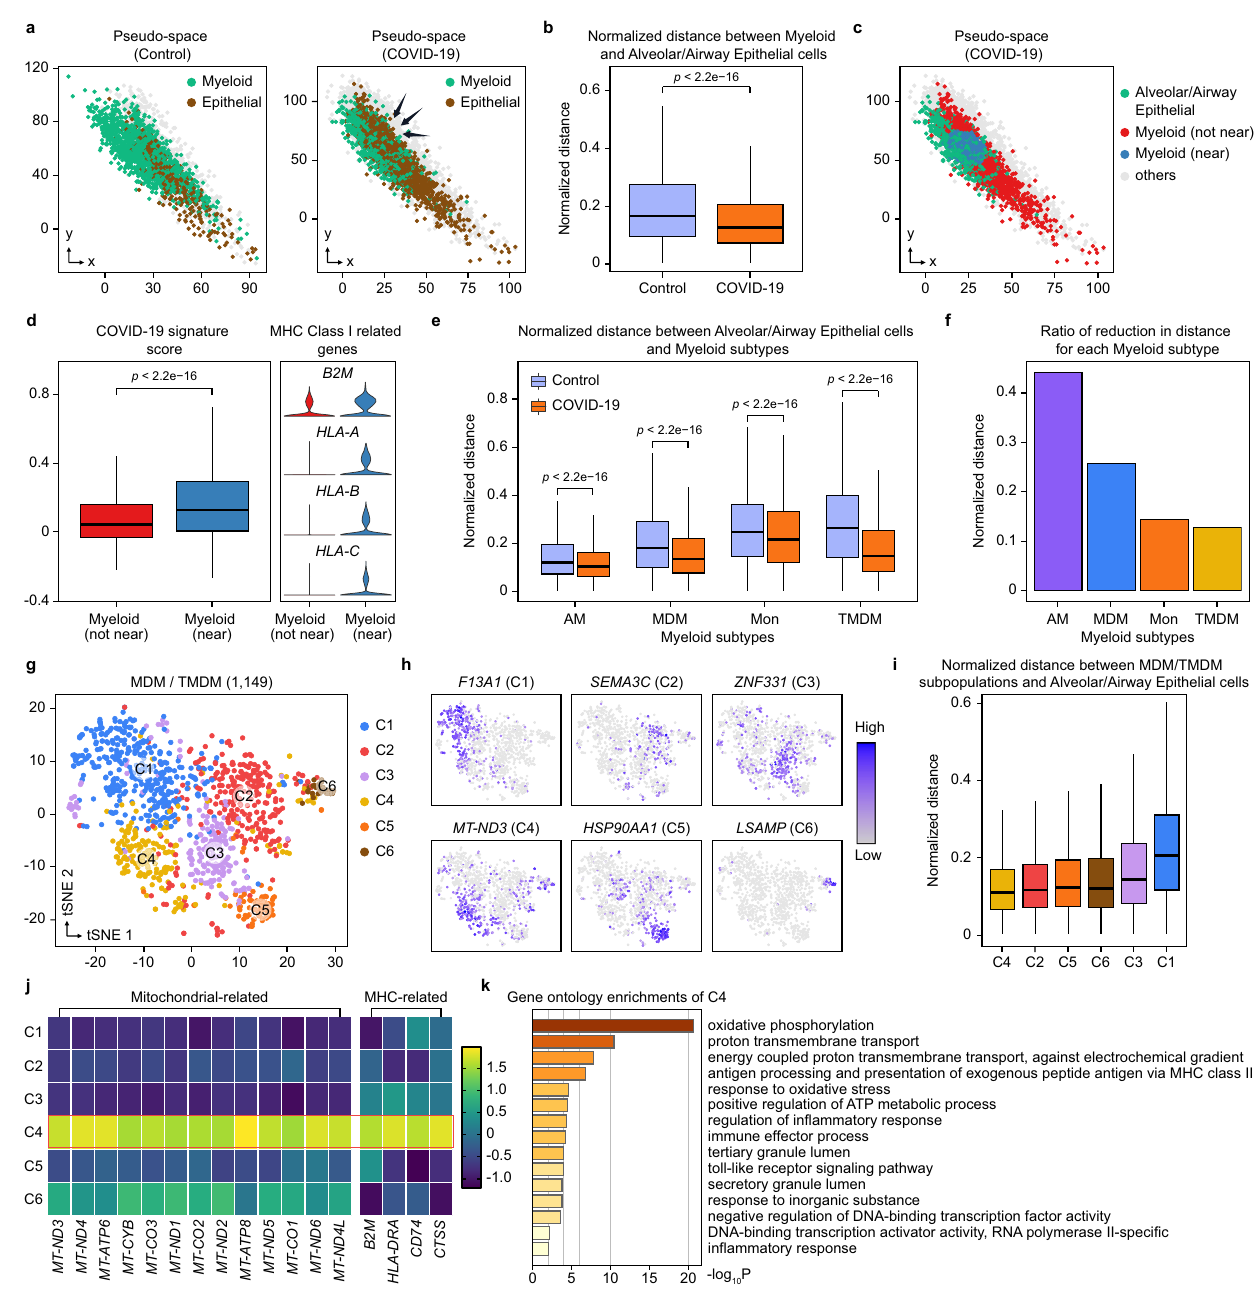
Fig. 6 | scSpace captures the invasion of myeloid subpopulations in COVID-19. a Reconstructed pseudo-space for control and COVID-19 groups. All other cell typesarelabeledas “ others ” . b Normalizedpairwisedistancebetweenmyeloidcells and alveolar/airway epithelial cells in the control and COVID-19 groups. Data are presented as boxplots (minima, 25th percentile, median, 75th percentile, and maxima).Thenumberofdatapointsfortheboxplotsfromlefttorightare548,877 and2,273,544,respectively. P -valueiscalculatedwiththetwo-sidedWilcoxonrank- sum test (the exact P -value is 0). c Pseudo-space for the COVID-19 group, wherein myeloid cells are divided into “ near to epithelial ” and “ not near to epithelial ” accordingtotheiraveragedistancestoalveolar/airwayepithelialcells.Allothercell typesarelabeledas “ others ” . d COVID-19signaturescores(Boxplot)andexpression levels of MHC-related genes (Violin) for two types of myeloid cells. Data are pre- sentedasboxplots(minima,25thpercentile,median,75thpercentile,andmaxima). Thenumberofdatapointsforeachtypeofmyeloidcellis1401. P -valueiscalculated with the two-sided Wilcoxon rank-sum test (the exact P -value is 4.1e − 20). e Normalized pairwise distances between myeloid subtypes and alveolar/airway epithelial cells in control and COVID-19 groups. Data are presented as boxplots